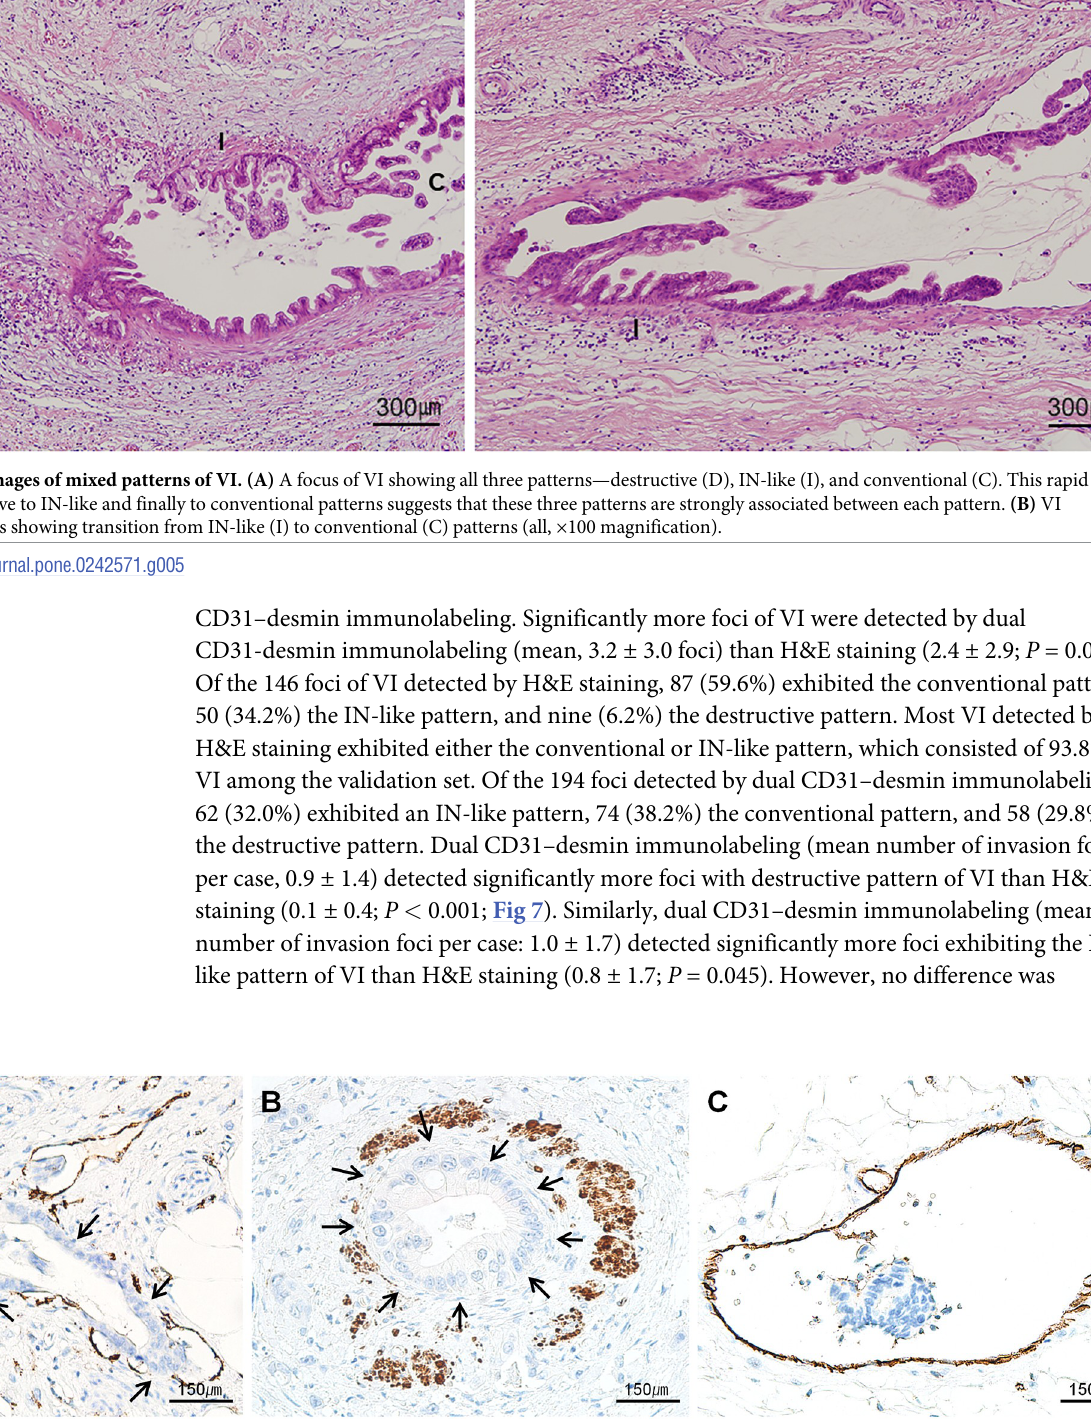
PLOS ONE | https://doi.org/10.1371/journal.pone.0242571 November30,